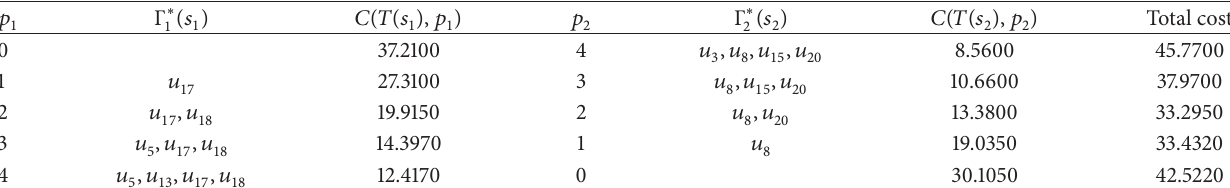
Table 1: Major data output by GLOB for (4,2) -CSOP CLP on 𝑇 .